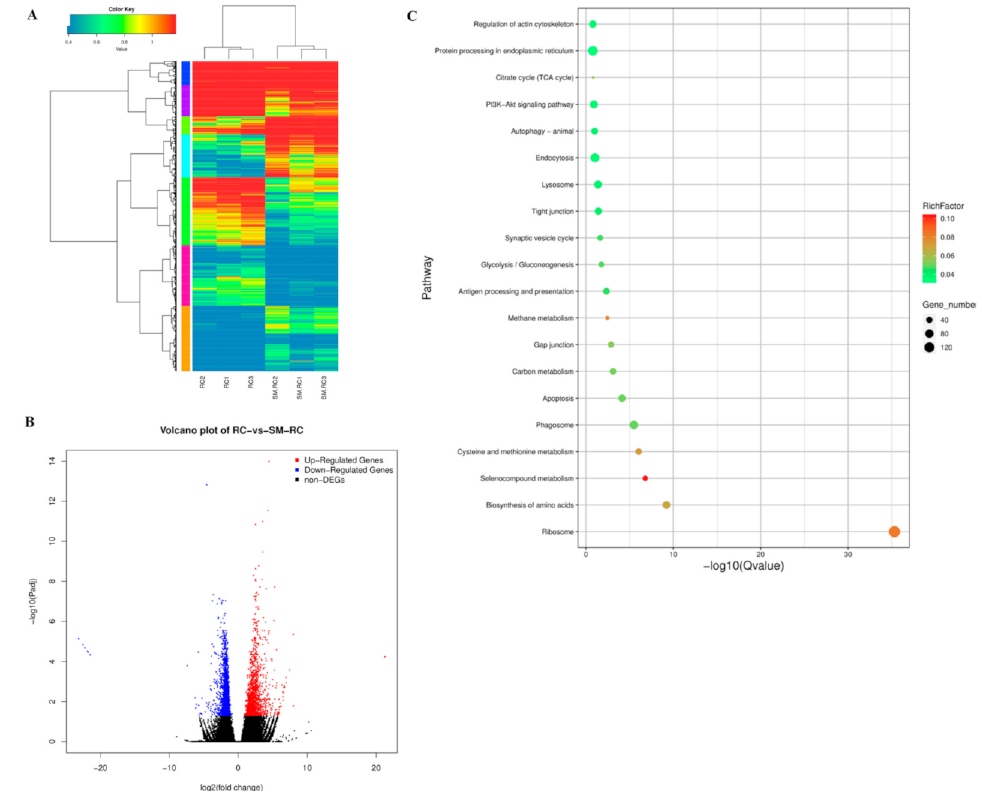
Figure 1. Overview of DEGs. ( A ) Heatmaps illustrating differences in normalized log signal in- tensities of the identified genes in R. chinensis . RC1, RC2, and RC3 represent the control group. SM-RC1, SM-RC2, and SM-RC3 represent the treatment group. Red bars indicate genes expressed at high levels, and blue bars indicate genes expressed at low levels. Color changes from blue to red indicate gradually increasing expression. ( B ) Volcano plots showing the DEGs between SM-RC and RC. Blue and red spots indicate significantly downregulated and upregulated genes, respectively. Black dots represent genes that are not differentially expressed. ( C ) The top 20 KEGG enrichments for differentially expressed unigenes in R. chinensis . The vertical axis indicates the name of the pathway, the names are sorted by Q value from low to high, and the horizontal axis indicates − log10 (Q value). The size and color of the dots indicate the number of DEGs and the corresponding RichFactor ranges,